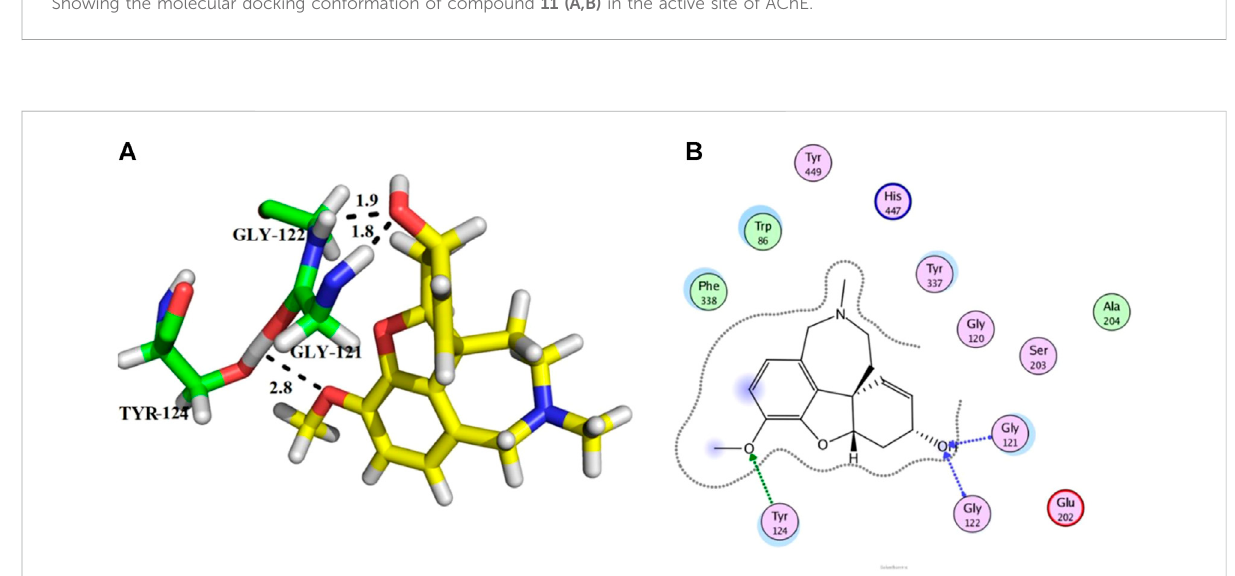
FIGURE 4 Showing the docking conformation of galanthamine ( A,B) (positive control) in the active site of